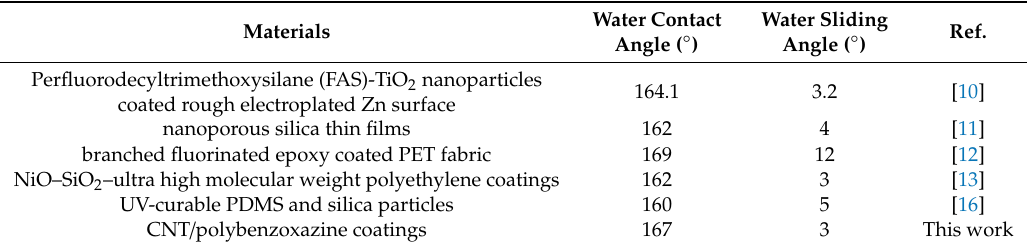
Table 1. Comparison of various durable superhydrophobic